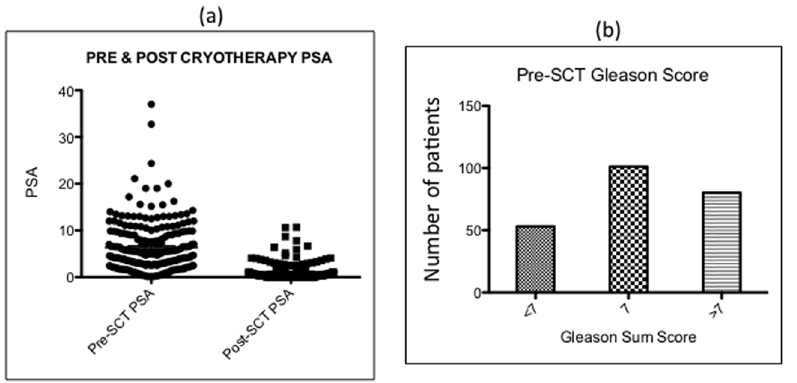
Figure 1. PSA and Gleason sum scores of SCT population. (a) Dot blot showing the pre and post-SCT nadir PSA for the entire patient cohort, (b) Bar chart representing the numbers of patients with different Gleason sum scores prior to SCT.